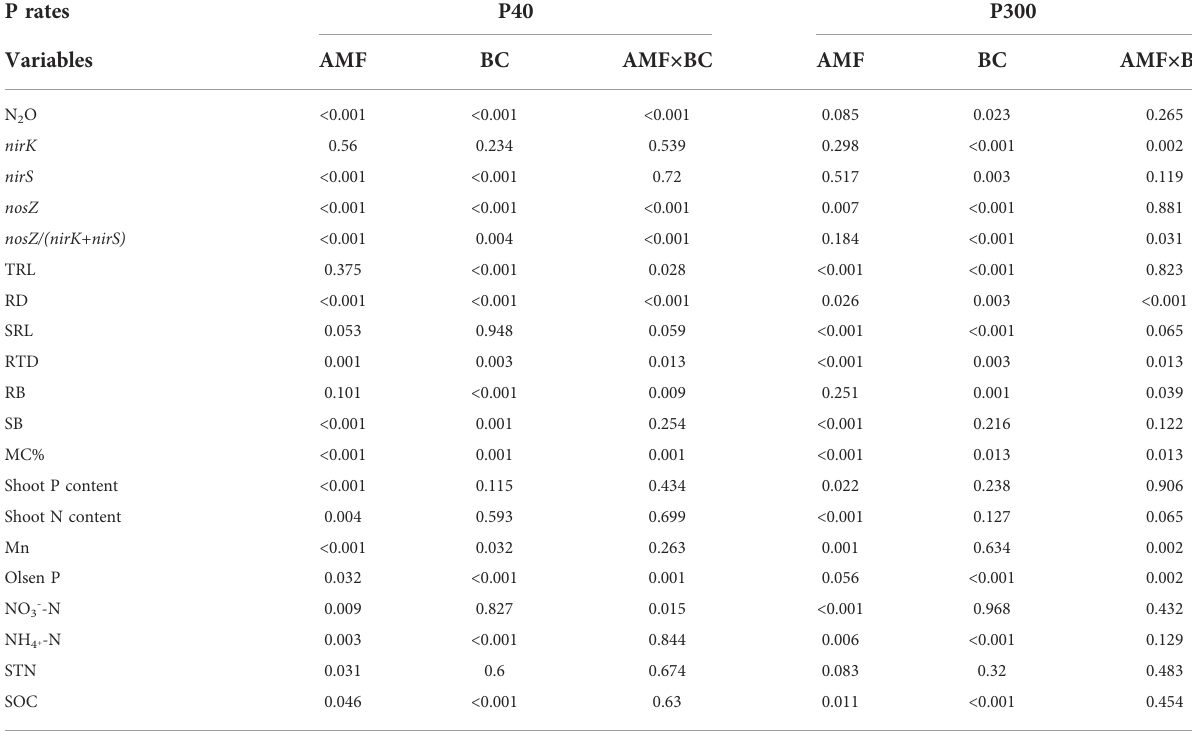
TABLE 1 The P values from 2-way ANOVA (AMF=arbuscular mycorrhizal inoculum and BC=biochar) at the two P rates (P40 and P300) regarding soil N 2 O emissions, gene abundance, and plant and soil properties in the greenhouse